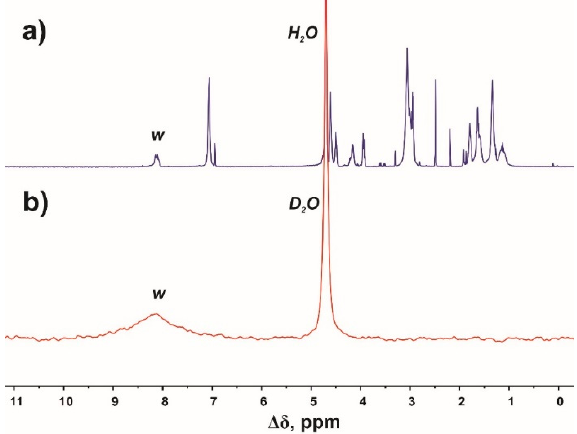
Figure 4. ( a ) 1 H and ( b ) 2 H NMR spectra of Lys-2His dendrimer in D 2 O after heating. 2 H NMR spectrum was recorded using a pulse sequence that suppresses the solvent signal. The letter symbols correspond to the designations of the groups in Figure 2.